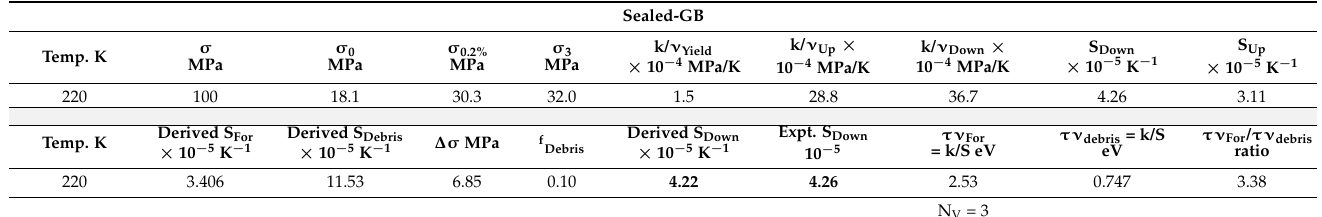
Table 3. Parameters to characterize linearized Haasen plot for Sealed-GB Al and